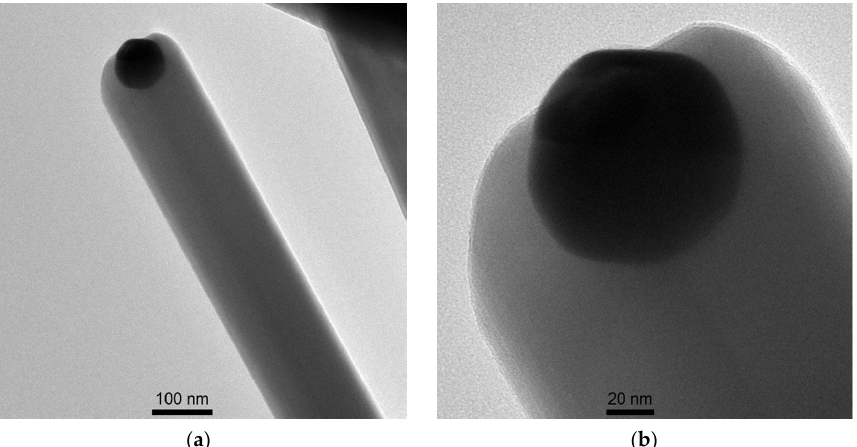
Figure 5. TEM image of ( a ) β -Ga 2 O 3 nanowire; ( b ) Droplet of Au or Au-Ga alloy droplet at the top of the nanowire.